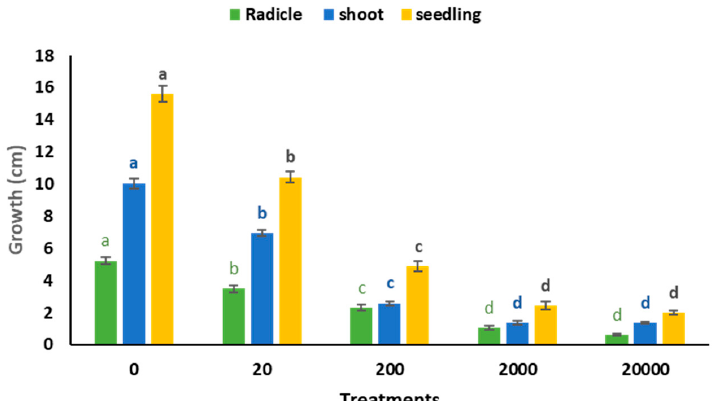
Figure 9. The growth response of radicles, shoots, and seedlings to varying concentrations of the fungicide Amistar Xtra. Means are presented ± SD ( n = 100). At p < 0.05, values between treatments marked by different letters differ significantly. They began in order, with the letter (a) being the most significant.